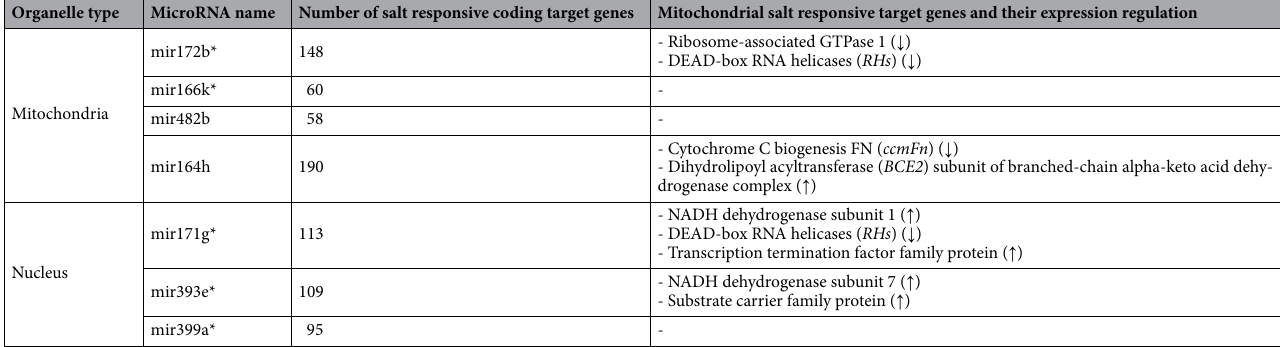
Table 1. Target prediction results of miRNAs related to selected markers and mitochondrial DNA fragment primers. *miRNAs in the structure of the selected miRNA-based markers, ( ↑ ) Upregulation, ( ↓ )